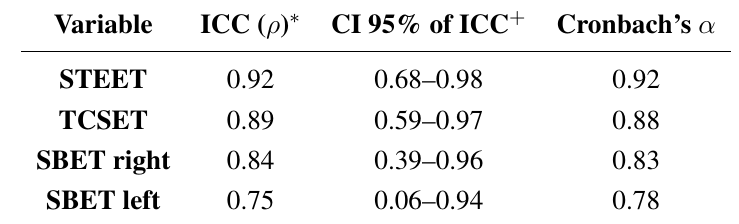
Table 3. Inter-rater reliability between traditional trunk endurance assessment and mDurance.